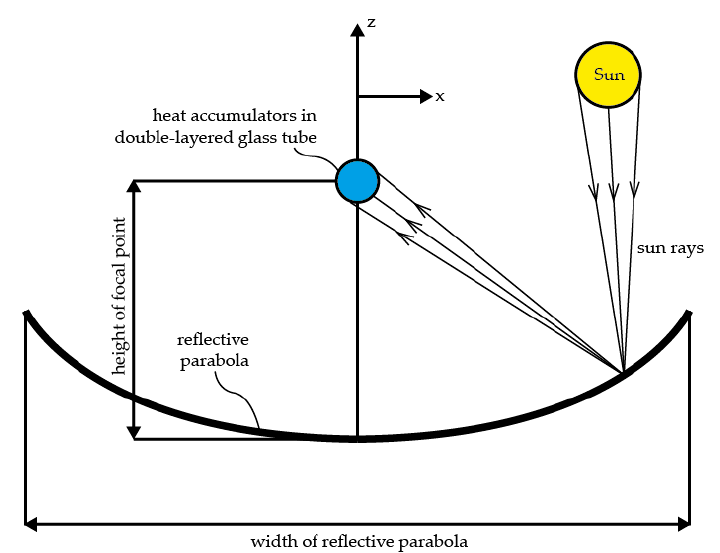
Figure 3. Basic principle of the proposed concentrated solar device.